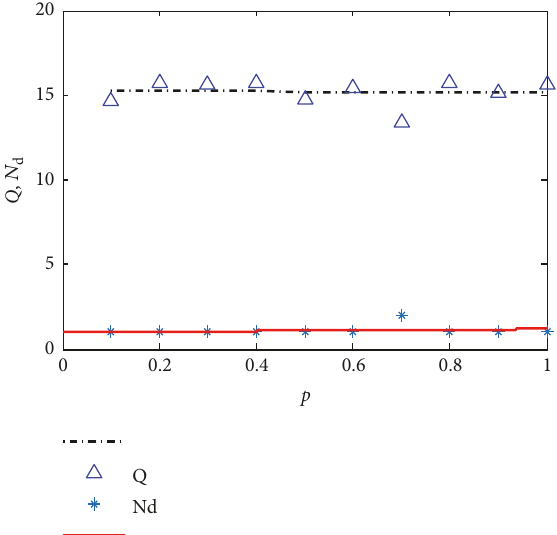
Figure 4: Trend of controllability and drive nodes of WS small- world network with 𝑝 varying across [0,1]